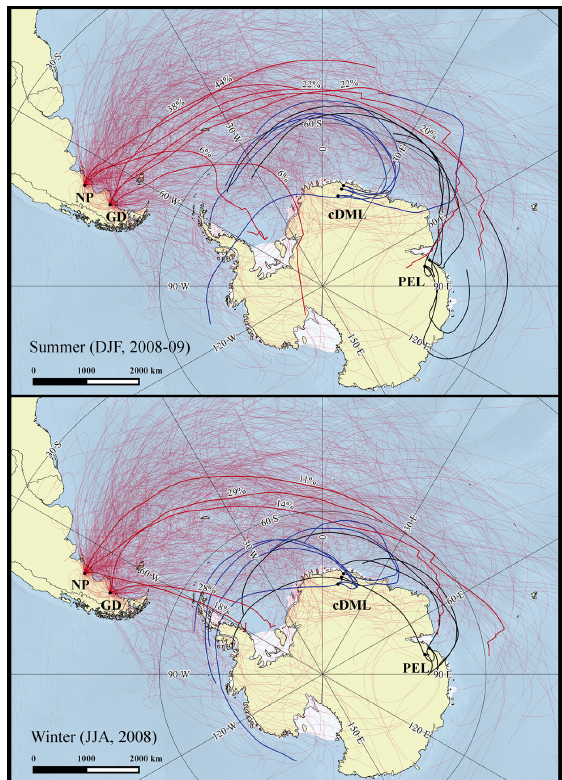
Figure 5. Forward- and back-trajectory analyses for 9 days using HYSPLIT model v.4 in conjunction with Global Data Assimilation System data set. The forward trajectories (red) were calculated from North Patagonia (NP) and San Julian’s Great Depression (GD), and the back trajectories (blue, black) were reconstructed from cDML and PEL. The cloud of thin red lines indicate clusters of 6-hourly forward trajectories while the thick red lines show the cluster av- erage. The thick blue and black lines from cDML and PEL region respectively indicate the cluster average of back trajectories calcu- lated during the same time